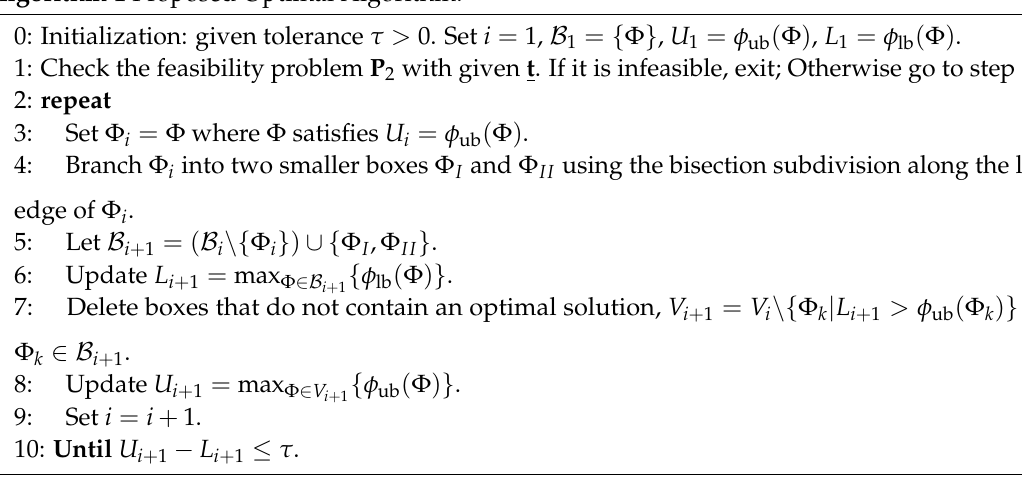
Algorithm 1 Proposed Optimal